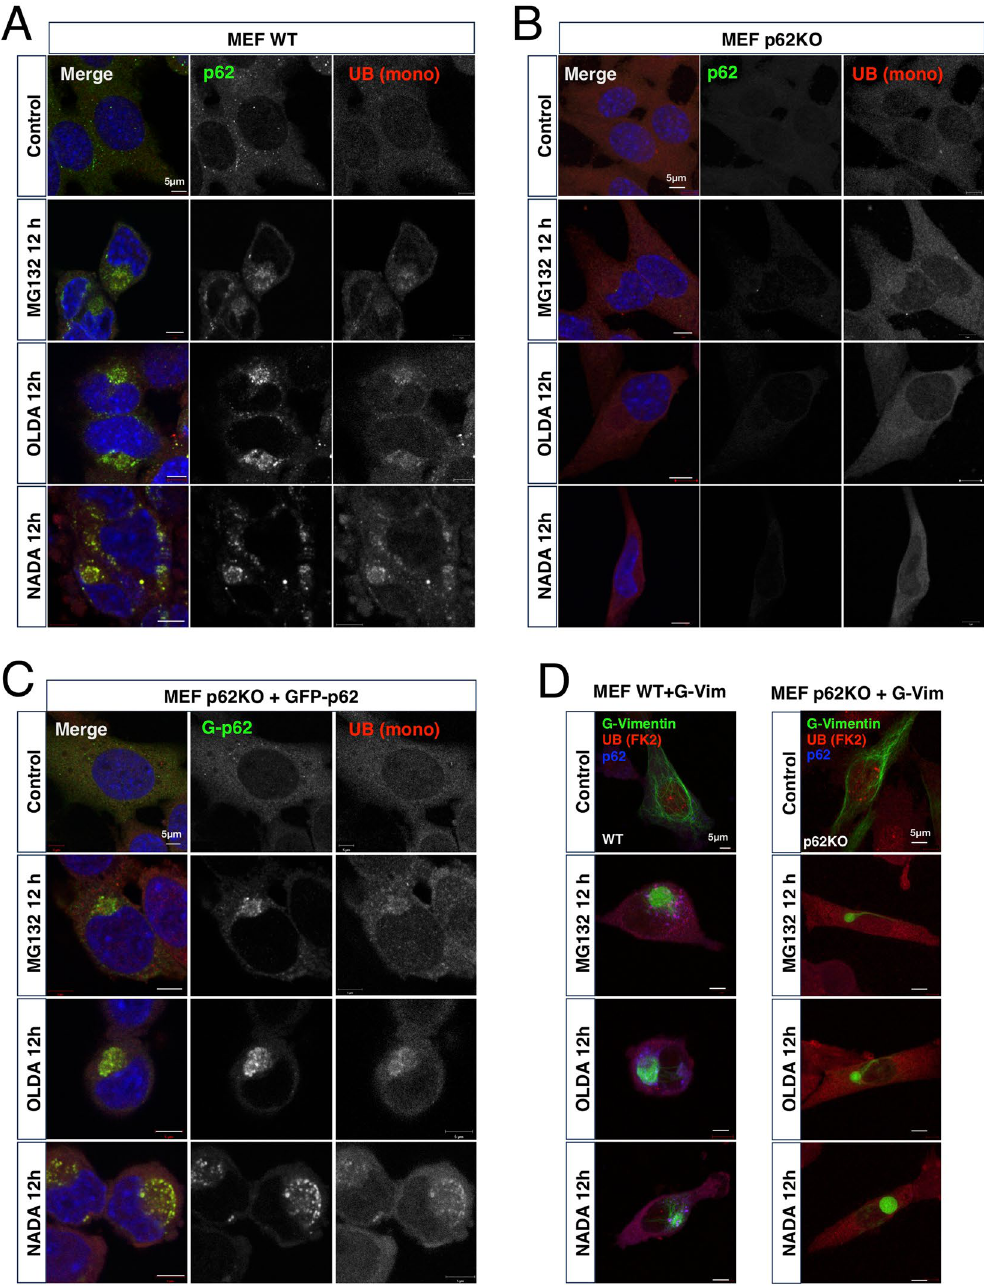
Figure 3. p62/SQSTM1 is essential for ubiquitinated protein accumulation in aggresomes, but is not required for vimentin cage formation. Wild-type MEF cells ( A ), p62 knockout MEF cells ( B ), or p62KO + GFP-p62 MEF cells ( C ) were treated with 1 µ M MG132, 5 µ M OLDA, or 5 µ M NADA for 12 h as indicated. Total p62 (green), ubiquitin monomer (UB (mono), red), and DAPI (nucleus, blue) were visualized by confocal microscopy as indicated. ( D ) GFP-Vimentin plasmid was transiently transfected in wild-type MEF or p62KO MEF cells for 24 h and treated with 1 µ M MG132, 5 µ M OLDA, or 5 µ M NADA for 12 h as indicated. GFP-Vimentin (green), multi-ubiquitin (UB (FK2), red), and p62 (blue) were visualized by confocal microscopy and merged images are shown as indicated. Scale bars represent 5 µ